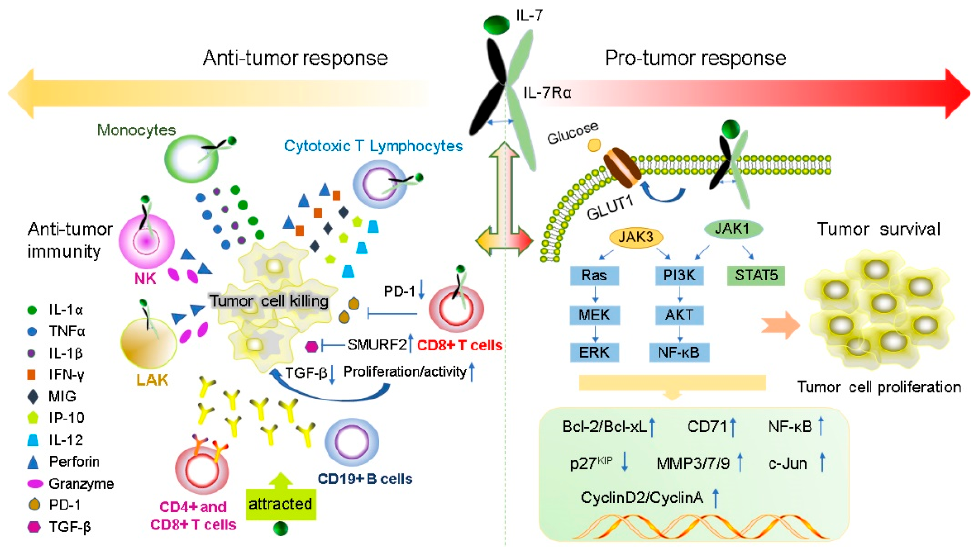
Figure 2. IL-7 and IL-7R have both pro- and anti-tumor functions. IL-7 plays anti-tumor roles by regulating immune cells to release cytokines such as IFN- γ , IL-1 β , IL-1 α and TNF- α . In contrast, IL-7 can promote the proliferation and survival of tumor cells by binding to the IL-7R to active JAK/STAT5, the PI3K/AKT and Ras/ERK signaling pathways to regulate gene expression levels of Bcl-2, Bcl-XL, CyclinA, CyclinD2, and p27 kip .